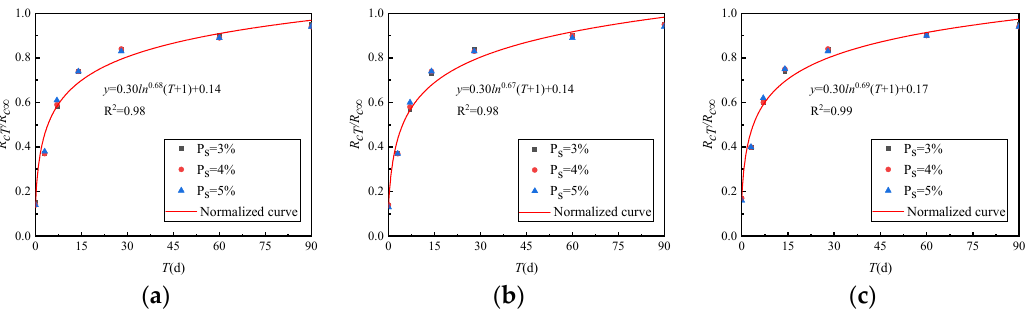
Figure 14. Growth law of R cT / R c ∞ between general grading and VGM-30. ( a ) GF1, ( b ) GF2, ( c ) VGM-30.